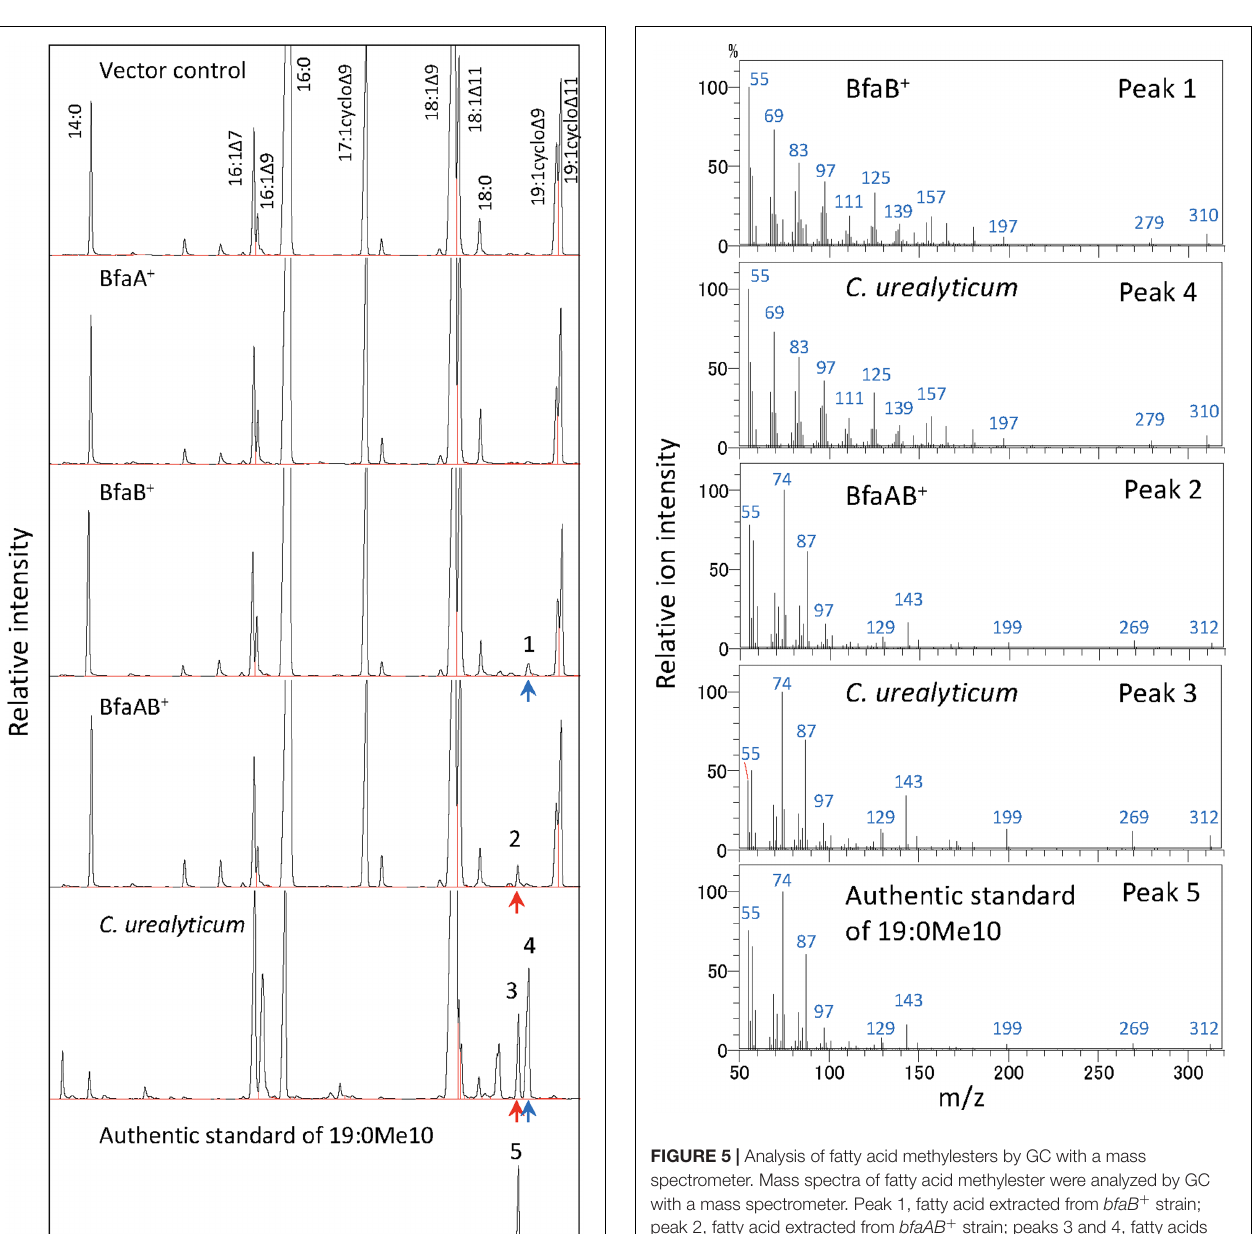
FIGURE 4 | Analysis of fatty acid methylesters by gas chromatography (GC) with a flame-ionization detector. Fatty acids were extracted from E. coli and C. urealyticum cells, methylesterified, and analyzed by GC-FID. 18:1 (cid:49) 9 (1 mM) was exogenously added to the culture of E. coli . BfaA and BfaB indicate the FAD-binding oxidoreductase and WP_048472121, respectively. Bottom panel indicate the result of the authentic standard of 19:0Me10. Peaks of the identified fatty acid methylesters were indicated as corresponding fatty acids. The retention times of methylesters of 19:0Me10 and 19:1Me10 were indicated by red and blue arrows, respectively. The numbers on the peaks in the Fig are corresponding to the MS analyses shown in Figure 5 .